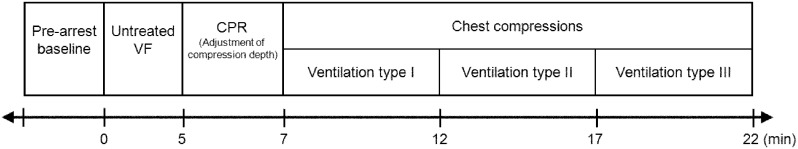
Experimental timeline.VF, ventricular fibrillation; CPR, cardiopulmonary resuscitation.